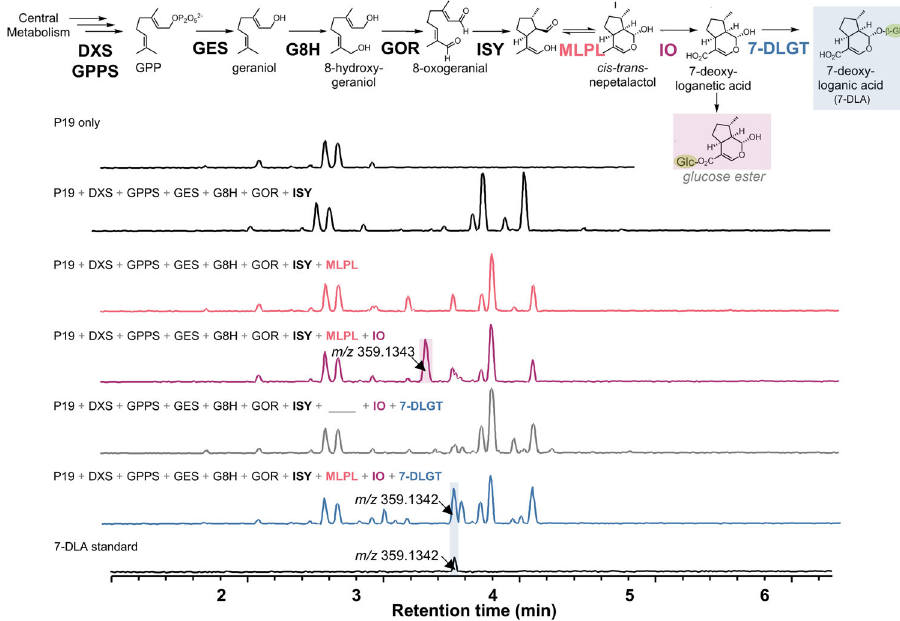
Fig. 4 MLPL1 from Nepeta mussinii enables 7-deoxyloganic acid production in N. benthamiana . Transient expression of all pathway enzymes plus MLPL produces a peak of 359.1342 m/z which matches the mass and retention time of a 7-deoxyloganic acid (7-DLA) standard. The reconstituted pathway without DLGT also produces a 359.1343 m/z peak but at a different retention time, likely due to endogenous glycosyltransferases of N. benthamiana producing the glucose ester of 7-deoxyloganetic acid. DXS, 1-deoxy-D-xylulose 5-phosphate synthase; GPPS, geranyl diphosphate synthase; GES, geraniol synthase; G8H, geraniol 8-oxidase; GOR, 8-hydroxygeraniol oxidoreductase; ISY, iridoid synthase; MLPL, major latex protein – like; IO, iridoid oxidase; 7- DLGT, 7-deoxyloganetic acid